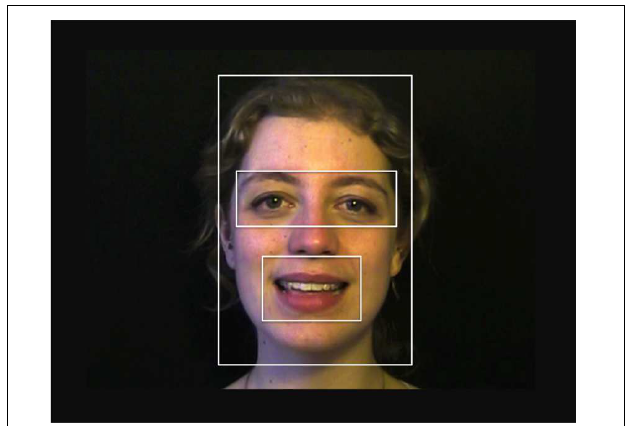
FIGURE 3 | The four regions of interest: eyes, mouth, rest of the face, rest of the screen.